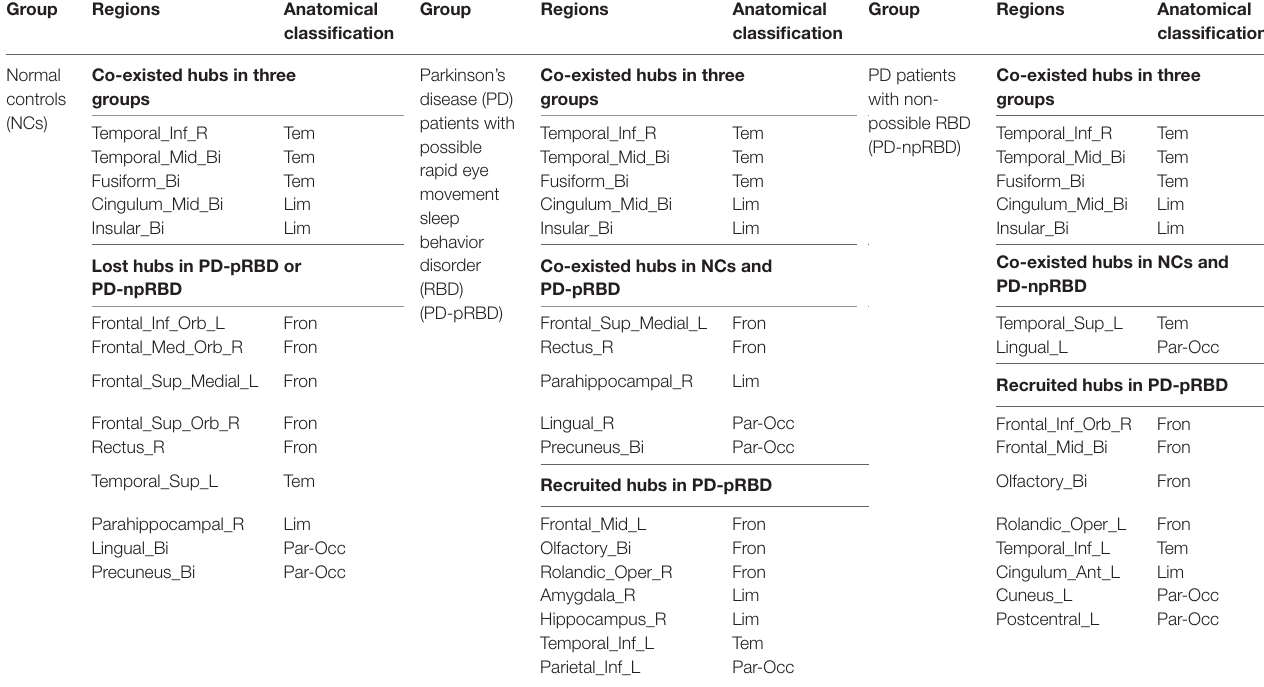
TaBle 4 | Hub distribution in patients and controls.